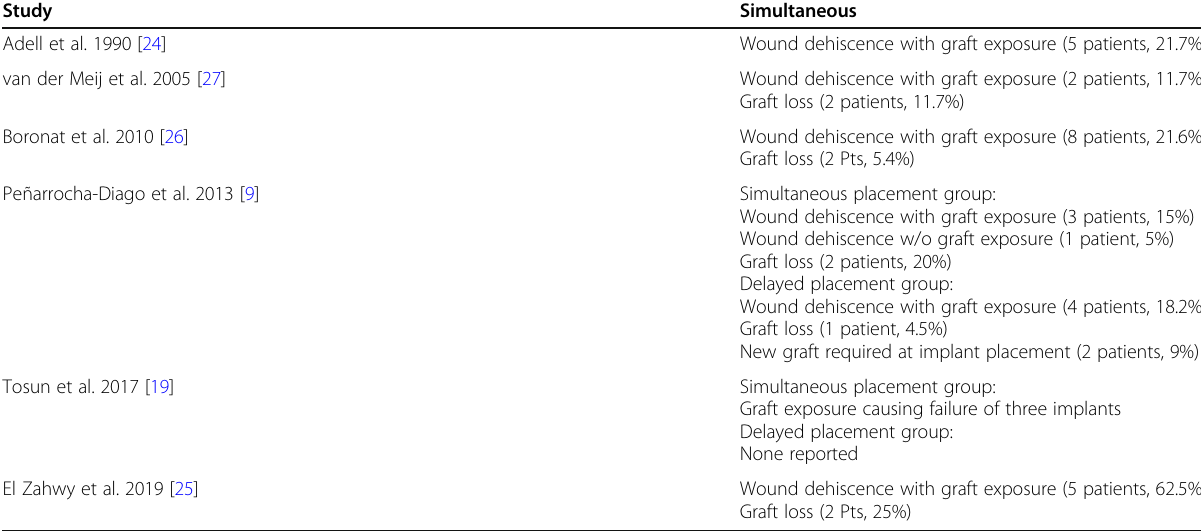
Table 3 Complications related to graft placement in the included studies Study